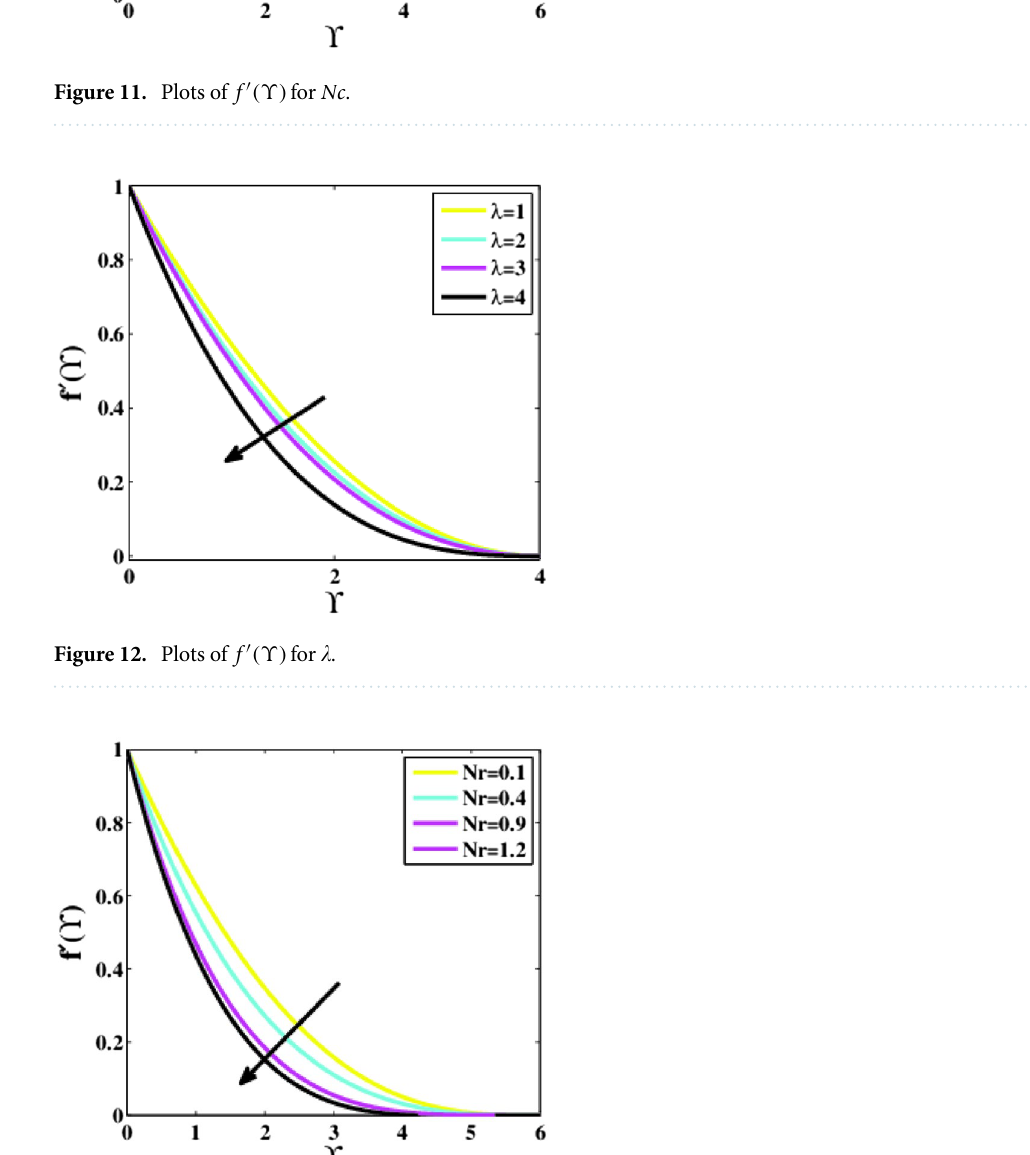
Figure 13. Plots of f